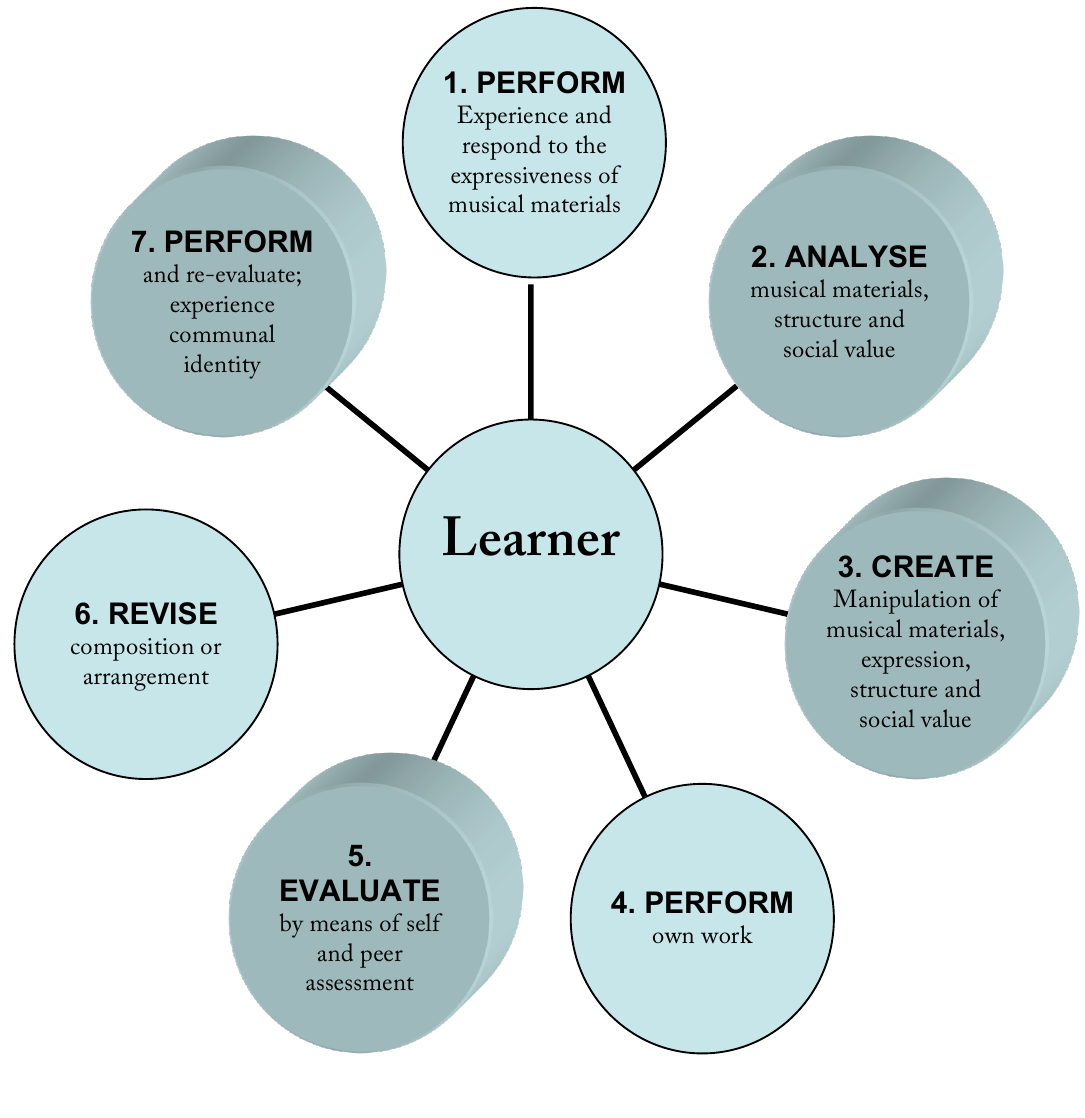
Fig. 1. Strategy for cultivating higher order thinking in music education, synthesised from Anderson and Krathwohl (2002:214), and Swanwick